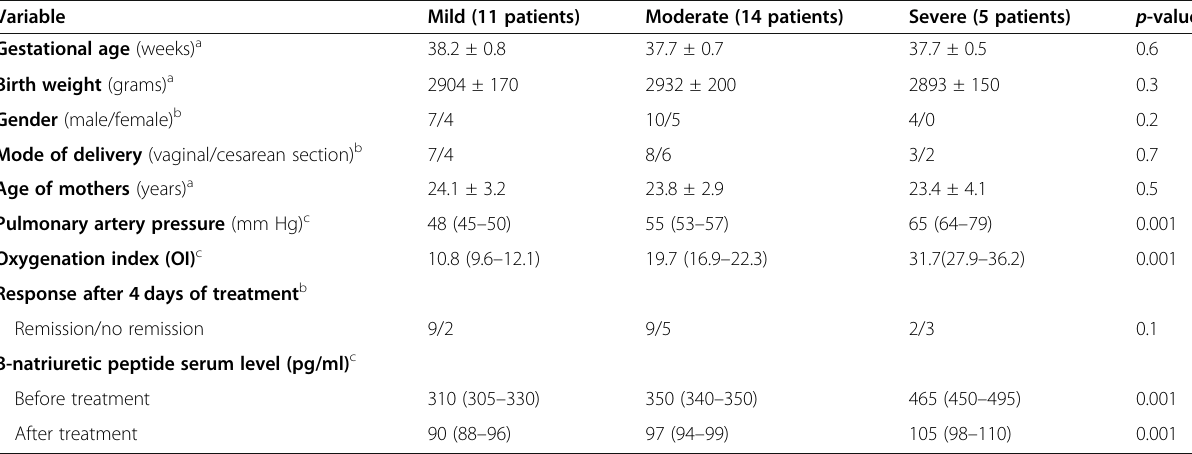
Table 1 Characteristics of patients ’ groups